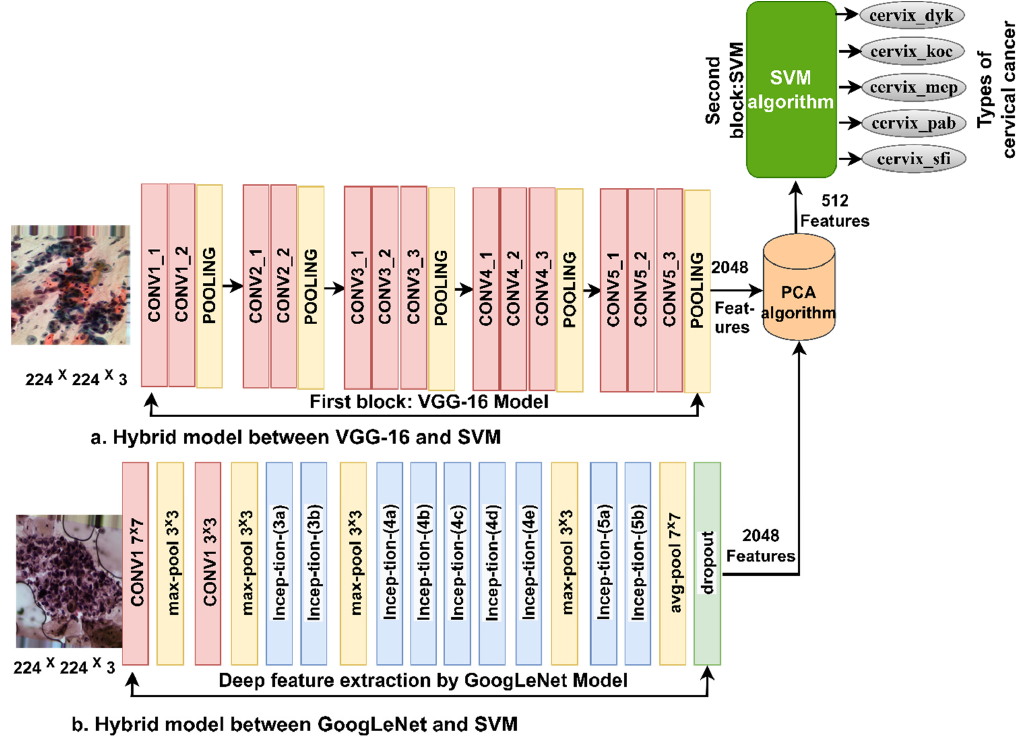
Figure 3. Framework of hybrid technique for diagnosing abnormal cell images for the cervical cancer data set.